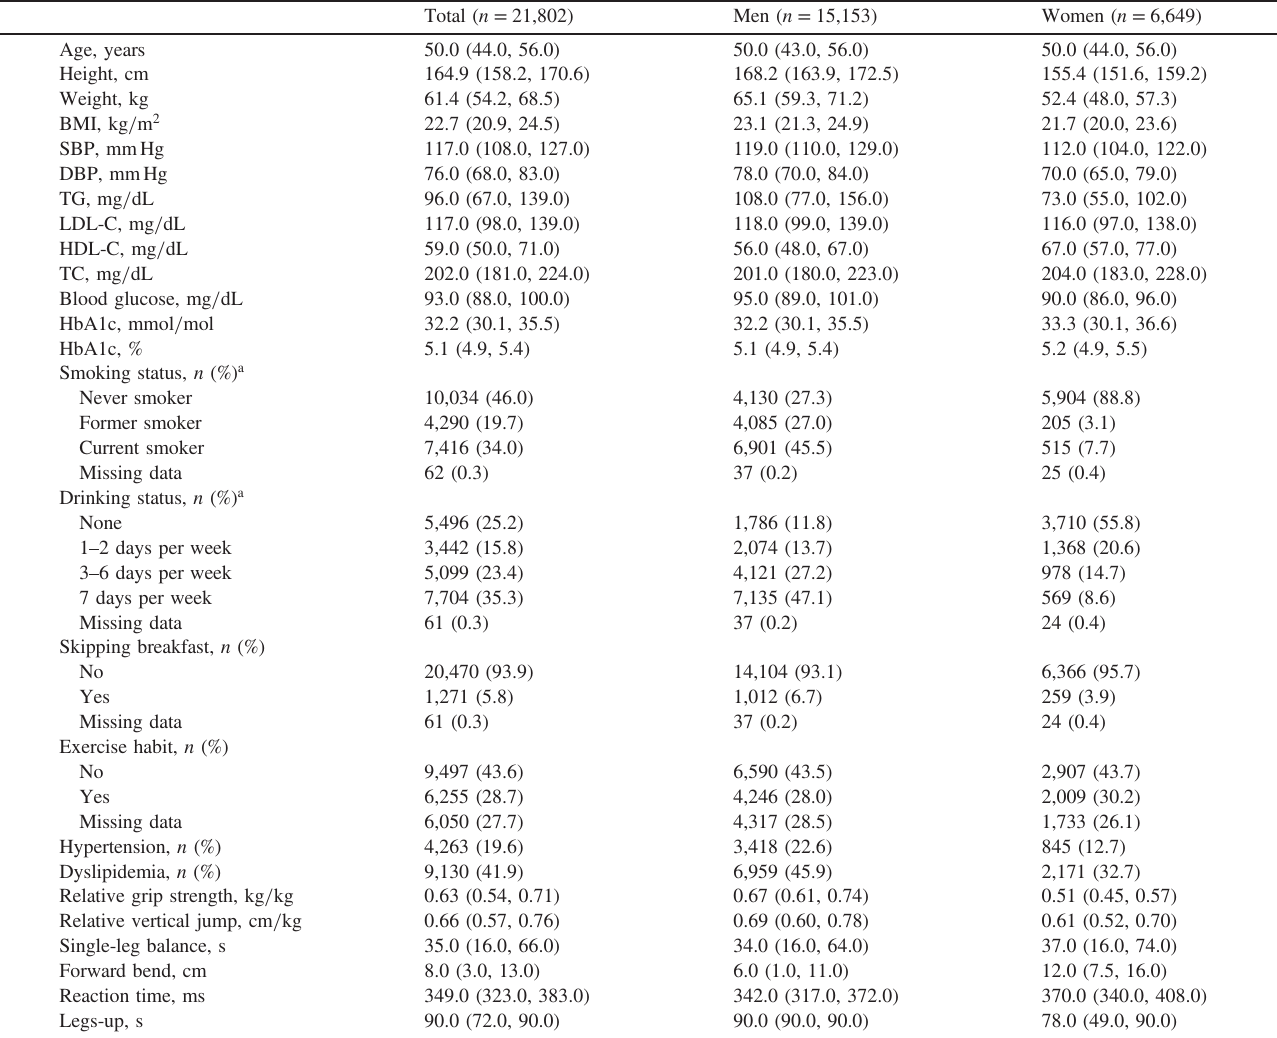
Table 1. Baseline characteristics of participants Age, years